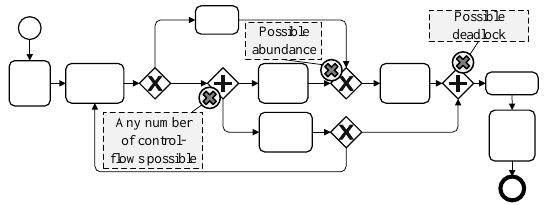
of the potential deadlock in the join node J 1